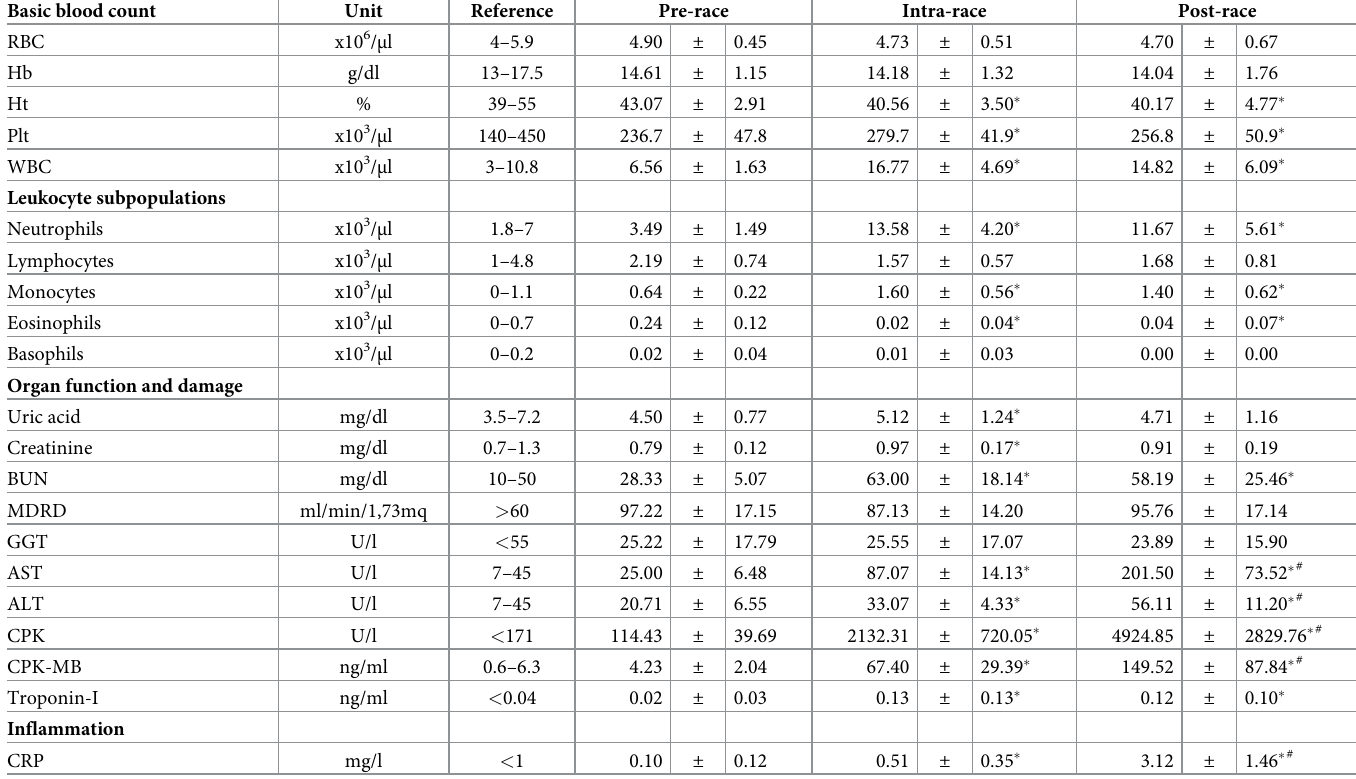
Table 2. Ultramarathon-induced changes in basic blood count, leukocyte subpopulations, markers of organ function and damage, and inflammation. Data, obtained from athletes which completed the race (n = 9), are corrected for Ht § and expressed as mean±SD. Basic blood